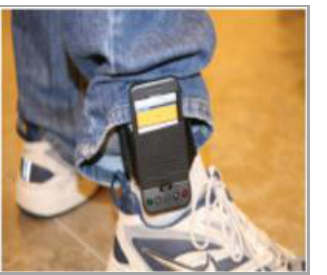
Figure 1. Installing a smart phone on the ankle of the user to count the steps (Parnandi et al,